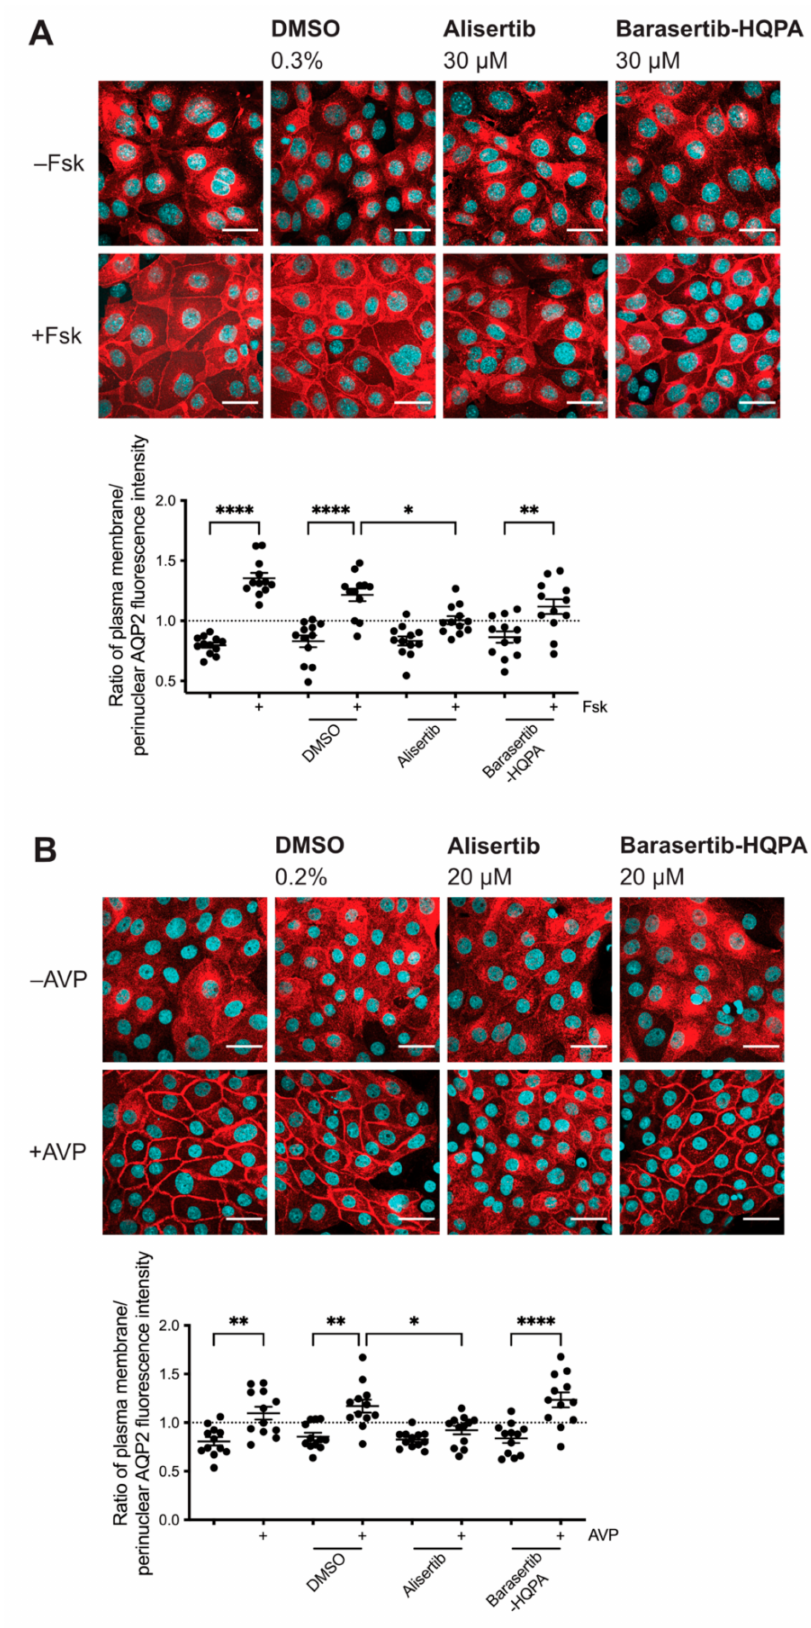
Figure 2. Inhibition of Aurora kinase A (AURKA) but not Aurora kinase B (AURKB) inhibits the redistribution of AQP2. ( A ) MCD4 or ( B ) primary IMCD cells were left untreated or treated